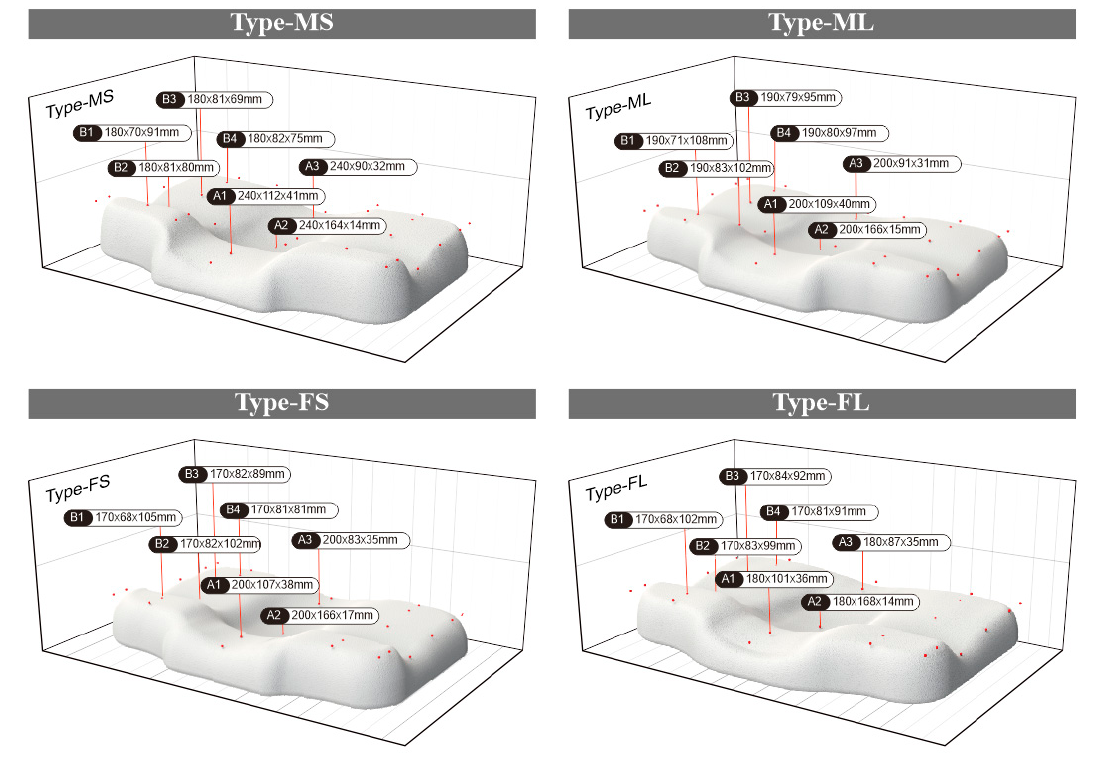
Figure 7. The morphology of zone 11 after four types of pillows are compressed.